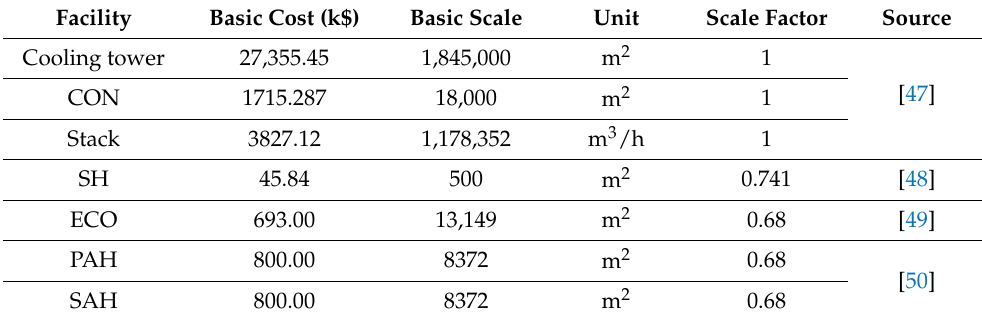
Table 18. Primary data of the scale-up method for the cost of several